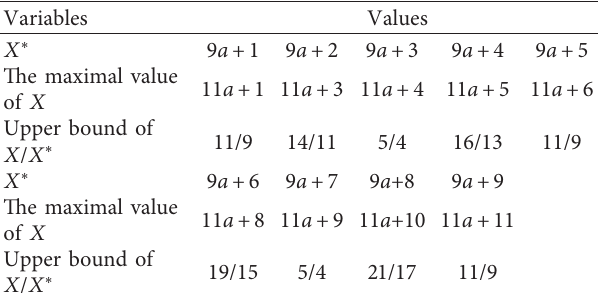
Table 2: The maximal values of X and the upper bound of X / X ∗ if X ∗ ≥